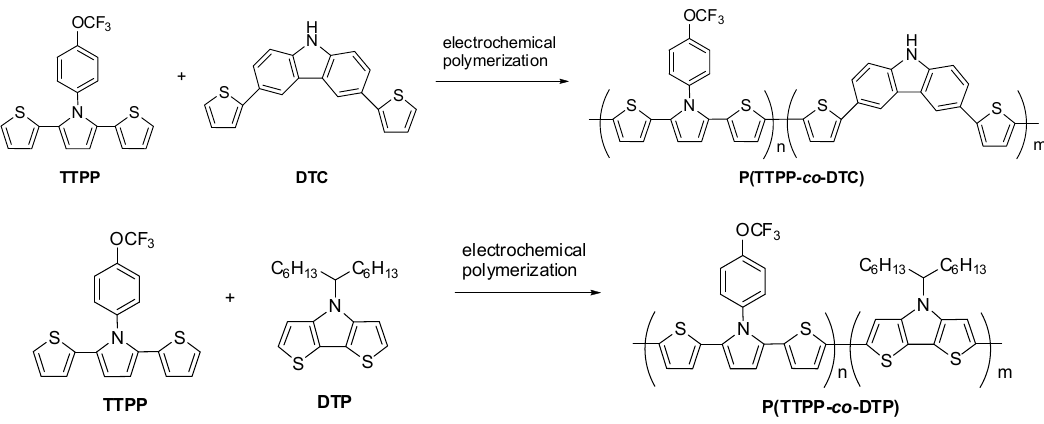
Figure 2. The electrosynthetic schemes of three 4 ‐ (trifluoromethoxy)phenyl ‐ containing PSNS.